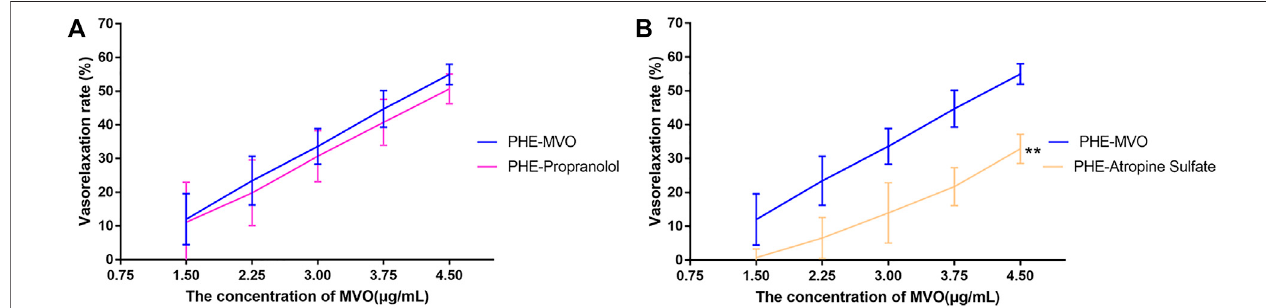
FIGURE 6 | Effects of (A) propranolol (1 μ M) or (B) atropine sulfate (1 μ M) on MVO-produced relaxant effects in +E aortic rings precontracted with PHE (10 μ M). The alternation of tension was expressed as the percentage of the active contraction induced by PHE (10 μ M). n = 6. Means ± S.D. * p < 0.05, ** p < 0.01 vs. PHE- MVO group.